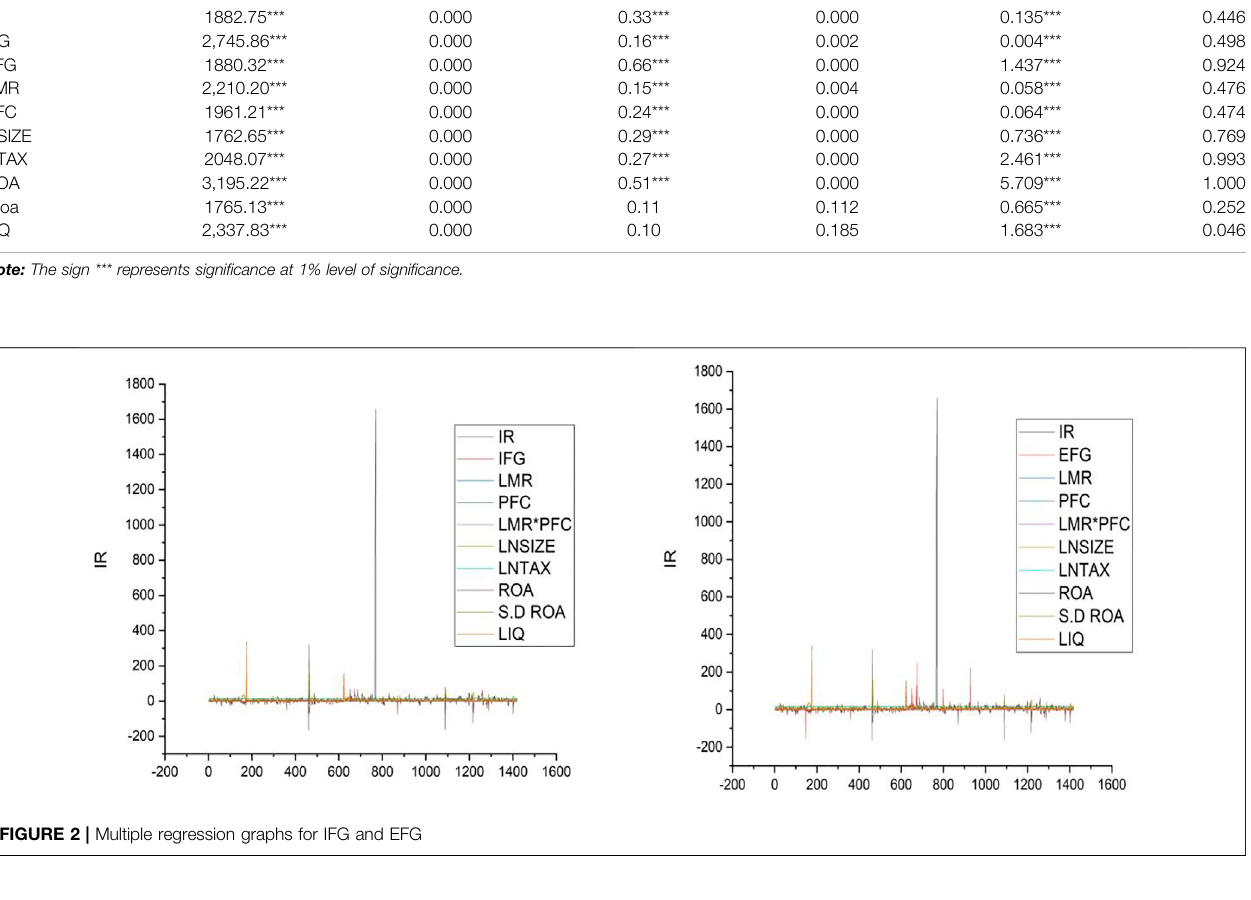
TABLE 5 | Heteroskedasticity, autocorrelation and cross-sectional dependence